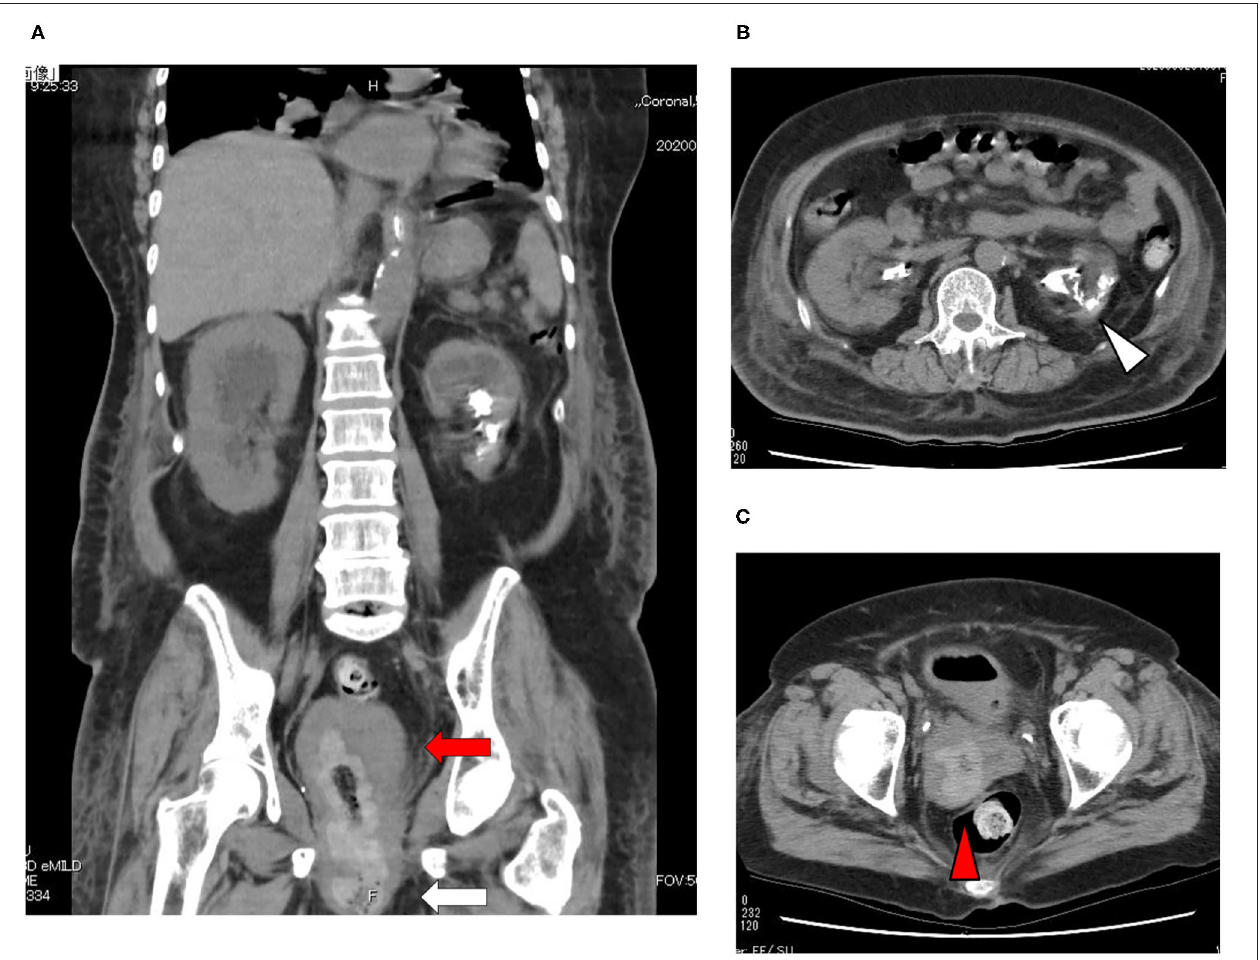
FIGURE 2 | (A–C) Abdominal and pelvic CT taken 10 days after admission. Abdominal and pelvic CT revealed that hydronephrosis was improved, although renal calculus was observed. In addition, pelvic CT revealed that lower shift of bladder (red arrow) and severe uterine prolapse (white arrow) were